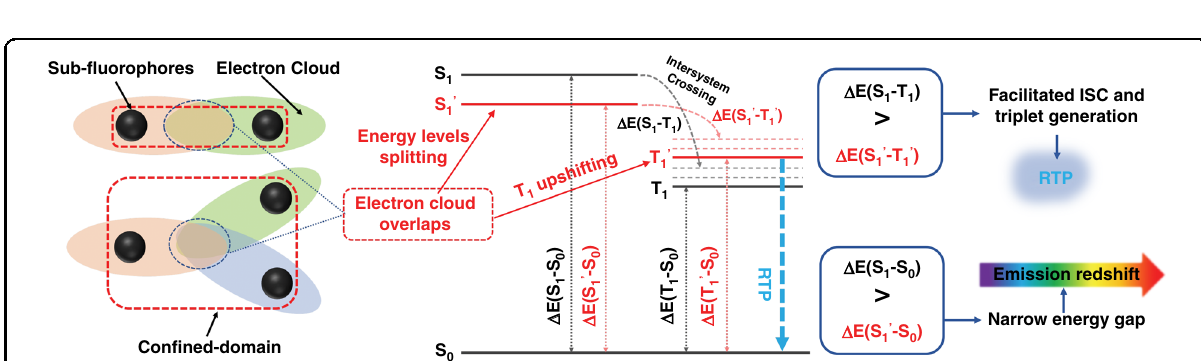
Sub-fluorophores Electron Cloud